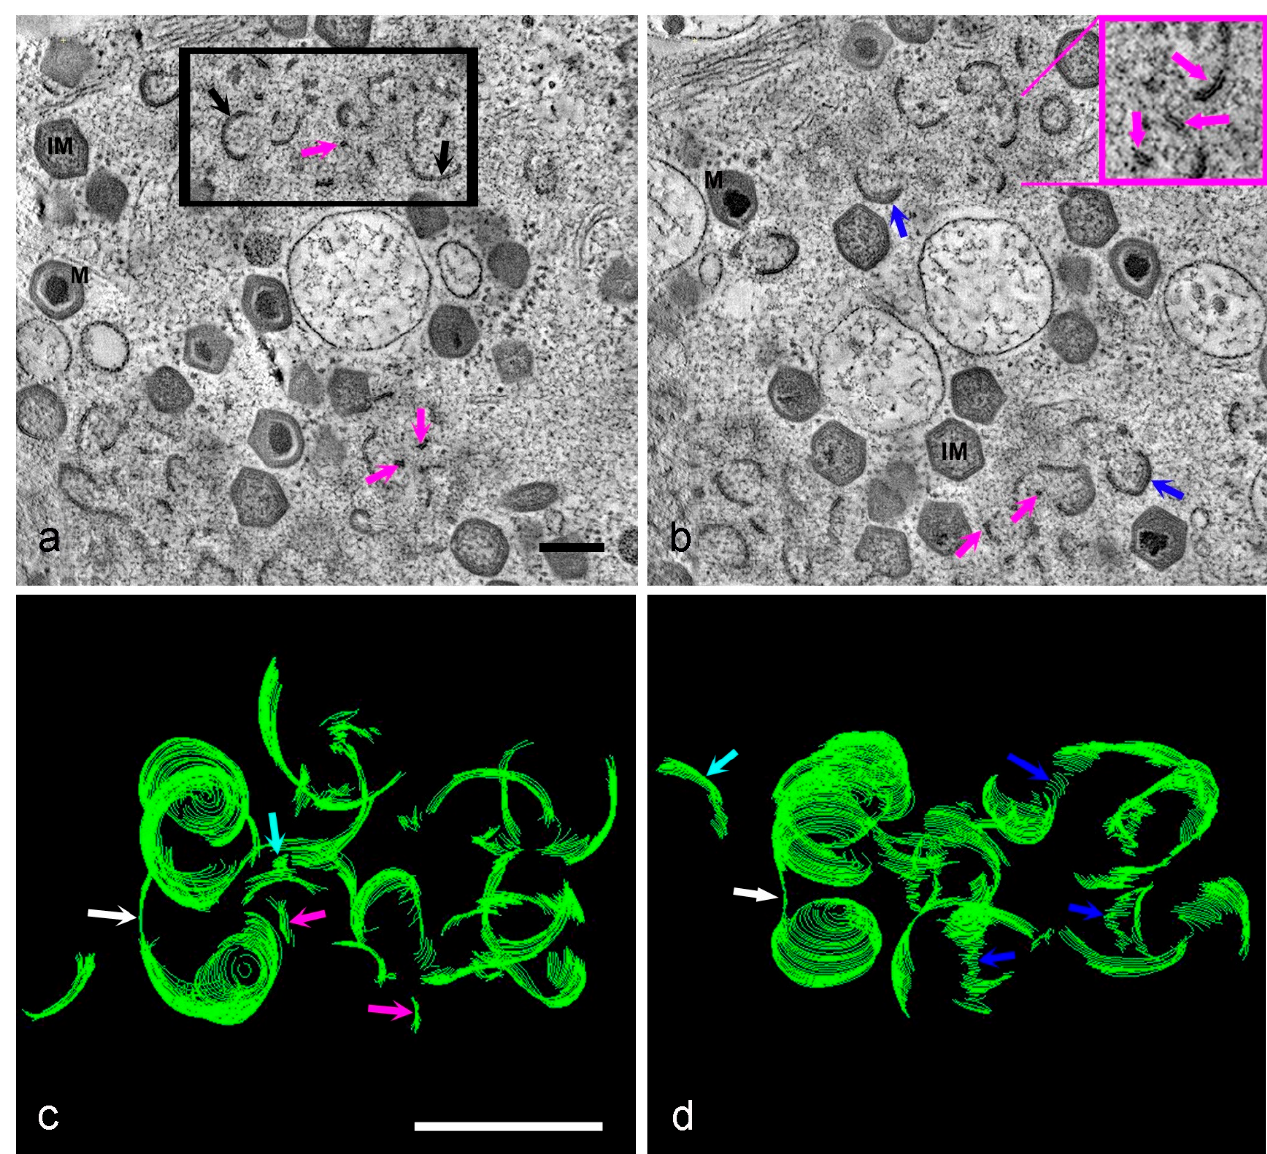
Figure 5. I. Tomographic reconstruction of HPF Vero cells at 18 hpi. ( a , b ) Two slices from the tomogram in supplemental data (Video S1). High-pressure freezing reveals the existence of small membrane fragments (pink arrows) and the clarity afforded by tomography shows the capsid and core proteins accumulating on the outer and inner faces of the later membrane assembly intermediates (blue arrows). The area within the black box in ( a ) was modeled in IMOD and then viewed from two different angles ( c , d ). Small, apparently individual, membrane fragments can be seen (pink arrows) alongside slightly larger curved membranes (light blue arrows) with a connection visible between curved pre-virions (white arrows). When viewed from a different angle, the membrane fragments appear to form links or bridges between larger intermediates (dark blue arrows). Scale bars = 200 nm.